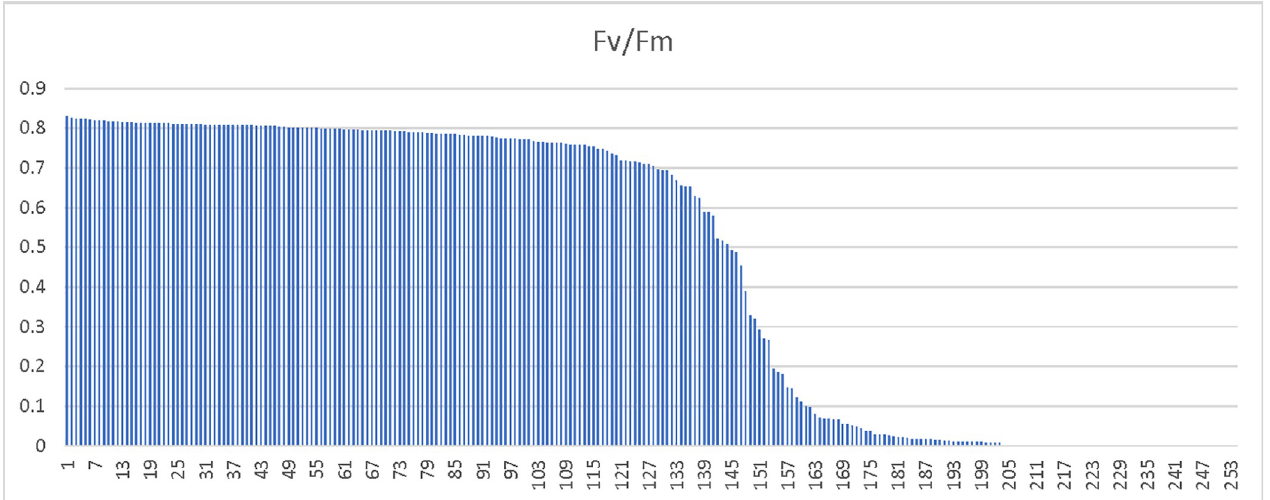
Fig 5. Chlorophyll fluorescence values from RIL families after low temperature stress. Chlorophyll fluorescence measures (Fv/Fm) for an individual from each of 254 F2:F5 RIL families two week following low temperature treatments described in the methods section. The Y axis represents the Fv/Fm values which are also indicative of physiological stress.